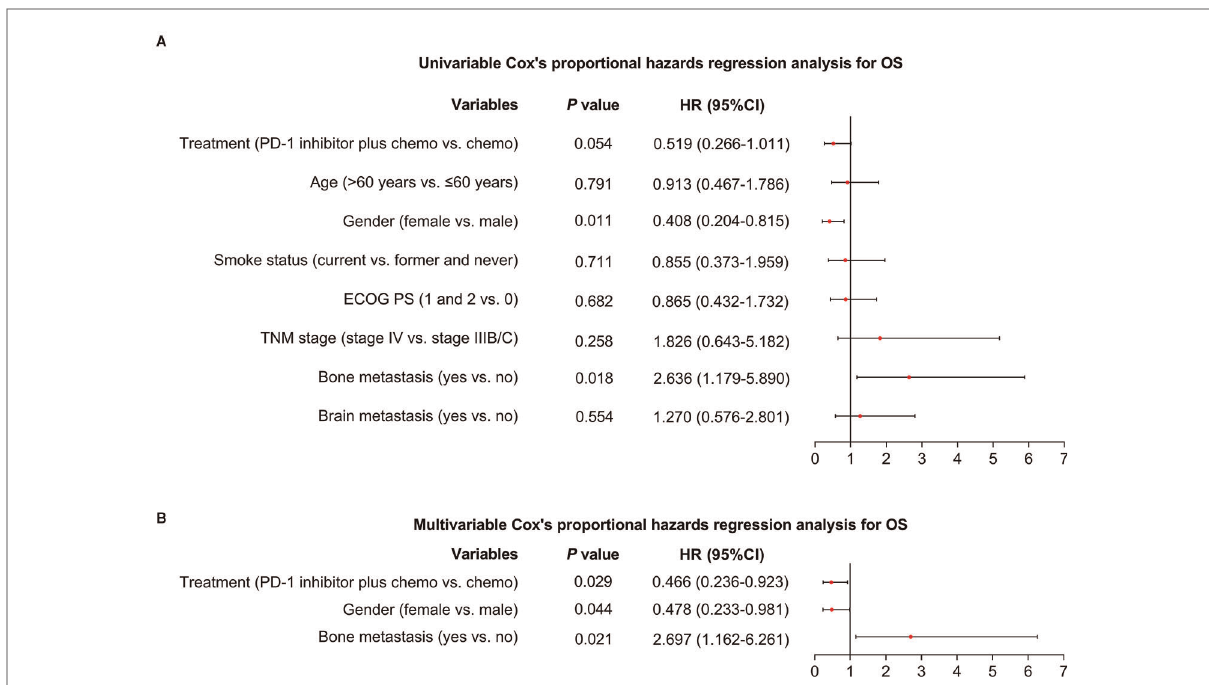
FIGURE 3 Factors affecting OS. Univariable ( A ) and multivariable ( B ) Cox ’ s proportional hazards regression analysis for OS in advanced driver-gene-negative nonsquamous NSCLC patients.